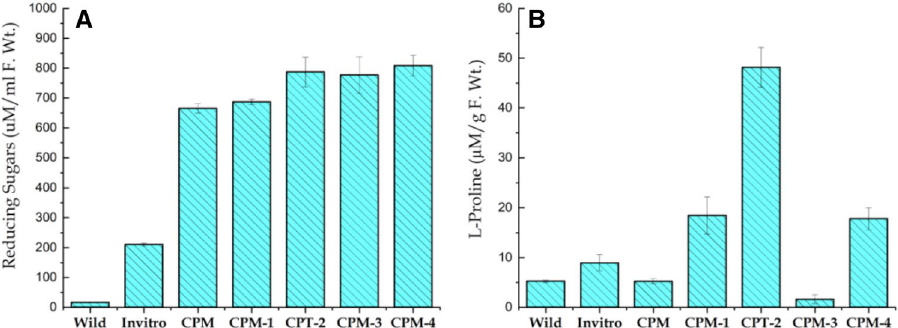
Figure 3. Variation in the Total Sugar contents ( A ) and proline contents ( B ) of S. costus collected from wild, in-vitro propagated plant and induced callus. Different stress for phytochemical comparison of callus grown on simple callus promoting media (CPM) supplemented with Kinetin (0.5 mgL -1 ) and 2.4-D (1.0 mgL -1 ) and callus subjected to various stresses i.e. 60 gL -1 D-Sorbitol stress (CPM-1), 60 gL -1 D-Manitol (CPM-2), 5 gL -1 Poly ethylene glycol 600 (CPM-3) and 60 gL -1 Sucrose